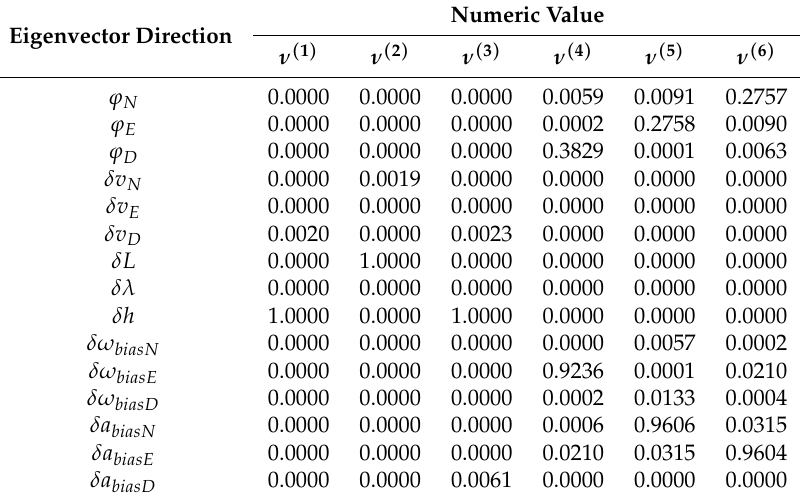
Table 5. Stationary eigenvectors ( t = 60 min) relative to the largest eigenvalues in the experimental